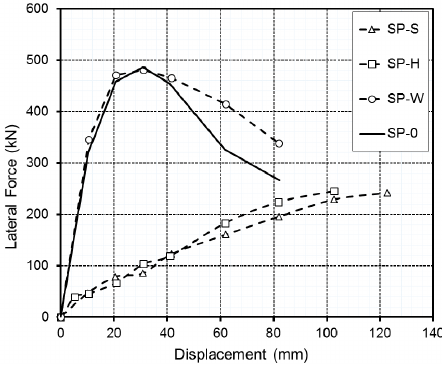
Figure 31. Load–displacement envelope curve.